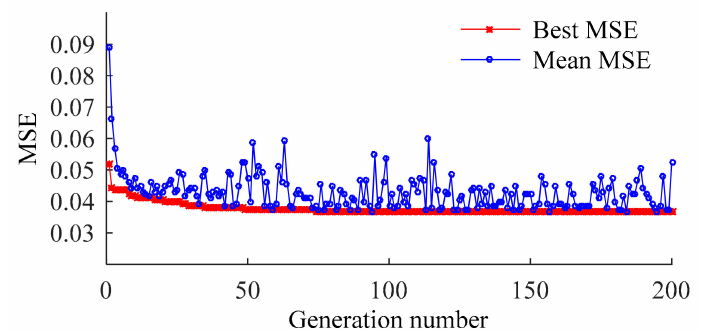
Figure 9. MSE values determined by GA.